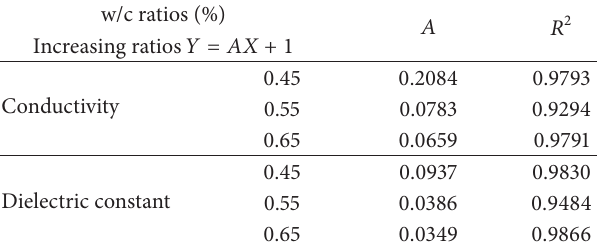
Table 5: Summary of the regression